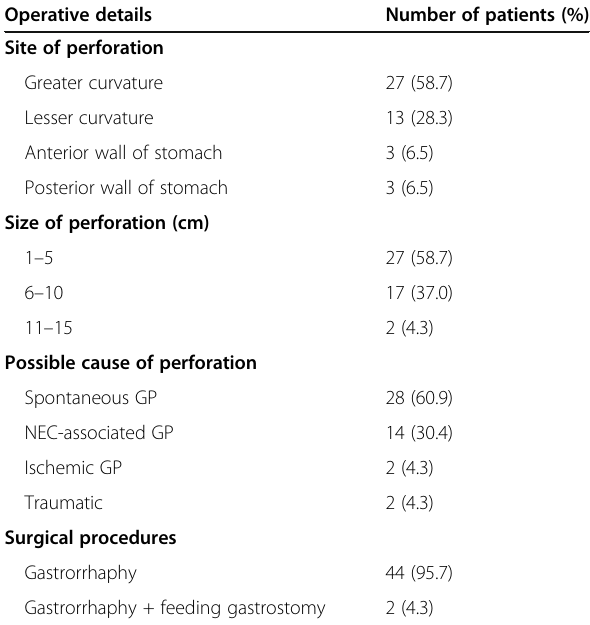
Table 2 Surgical findings and operative details of patients Operative details